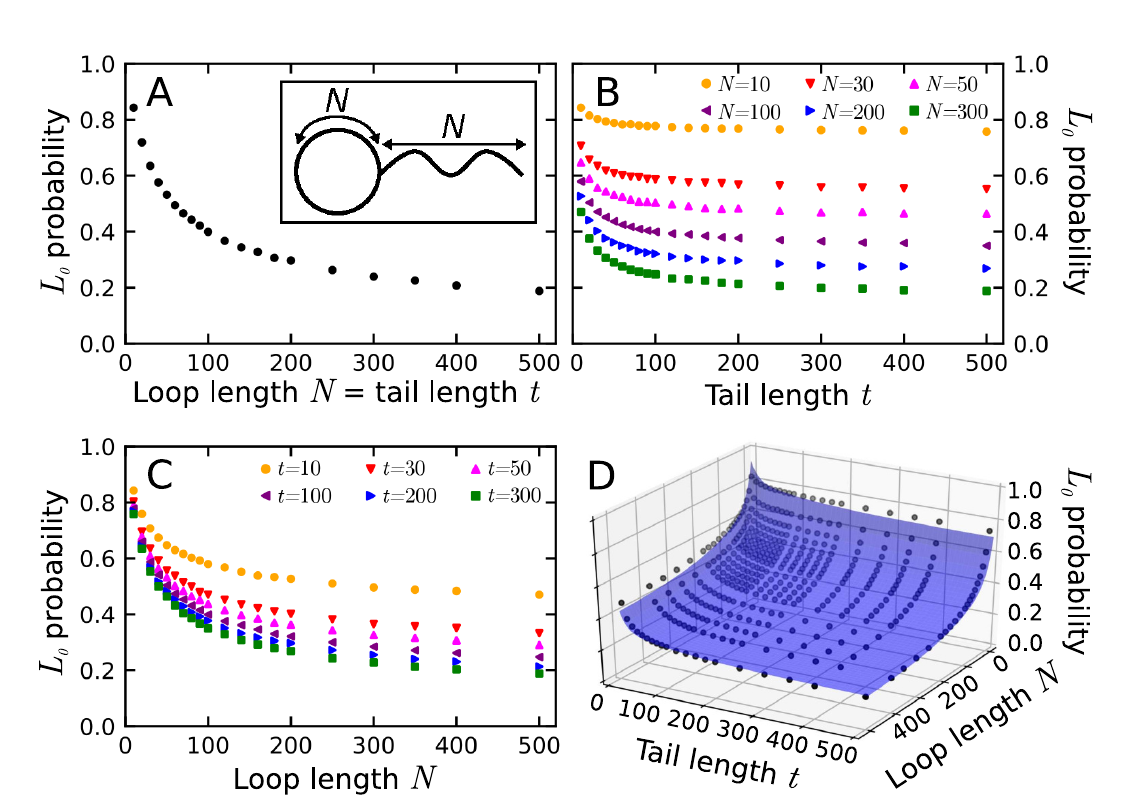
Figure 3. The probability of trivial lassos. ( A ) A plot of the probability for an equal length of the tail t and the loop N . In the inset, the schematic structure of trivial lasso; ( B ) Probability of trivial lasso vs tail length t for fixed loop length N ; ( C ) Probability of trivial lasso vs loop length N for fixed tail length t ; ( D ) The surface of trivial lasso probability in the space of loop and tail length. In the case of ( B ) and ( C ) only selected traces were plotted to maintain transparency. For all the data see Section S2 of Supplementary